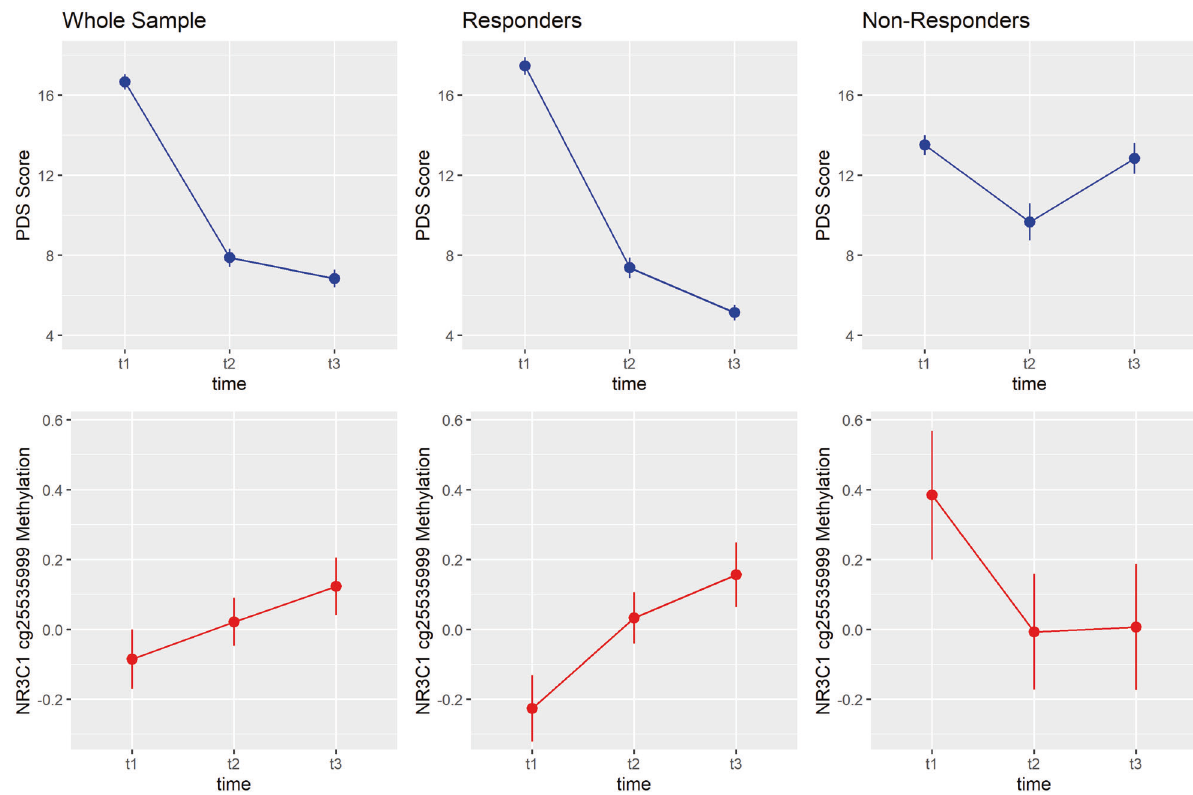
Fig. 1 Mean values and standard errors of measurement for PTSD symptoms (upper panel) and NR3C1 cg25535999 methylation (lower panel) over the three points of measurement. The plot separately displays the results for the whole sample ( N = 153), responders ( N = 116), and non-responders ( N = 33). PDS, Posttraumatic Diagnostic Scale; t 1 , pretreatment; t 2 , 4 months posttreatment, t 3 , 10 months